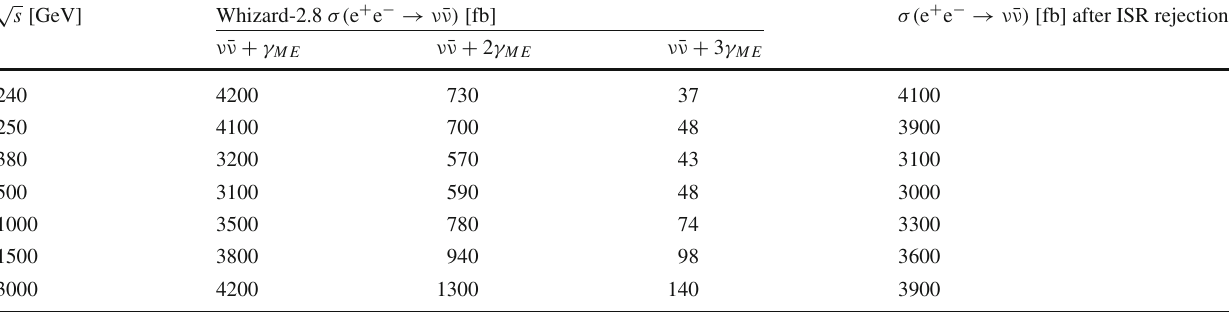
Table 3 Cross section values for (radiative) ν ¯ ν events, for different collision energies and different multiplicities of photons included in matrix element calculations with a requirement of at least one of the matrix elements photons to be ’hard’. Number of significant digits indicates the statistical precision resulting from Whizard integration √ s [GeV]